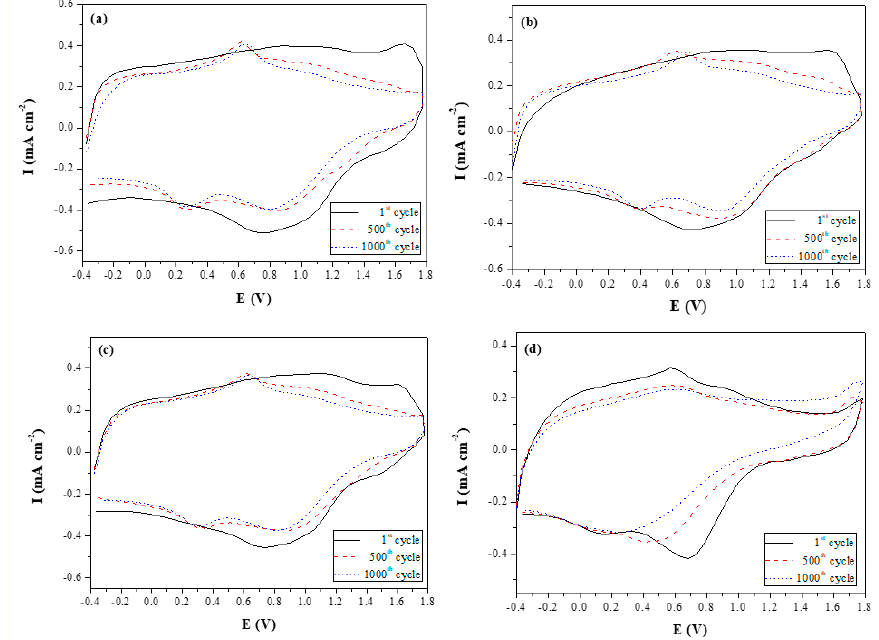
Figure 11. Cyclic voltammograms of ( a ) PbCmB/PEDOT, ( b ) P(bCmB- co -bTP)/PEDOT, ( c ) P(bCmB- co -dbBT)/PEDOT, and ( d ) P(bCmB- co -TF)/PEDOT ECDs as a function of repeated cycles with a scan rate of 500 mV s − 1 between 1 and 1000 cycles.